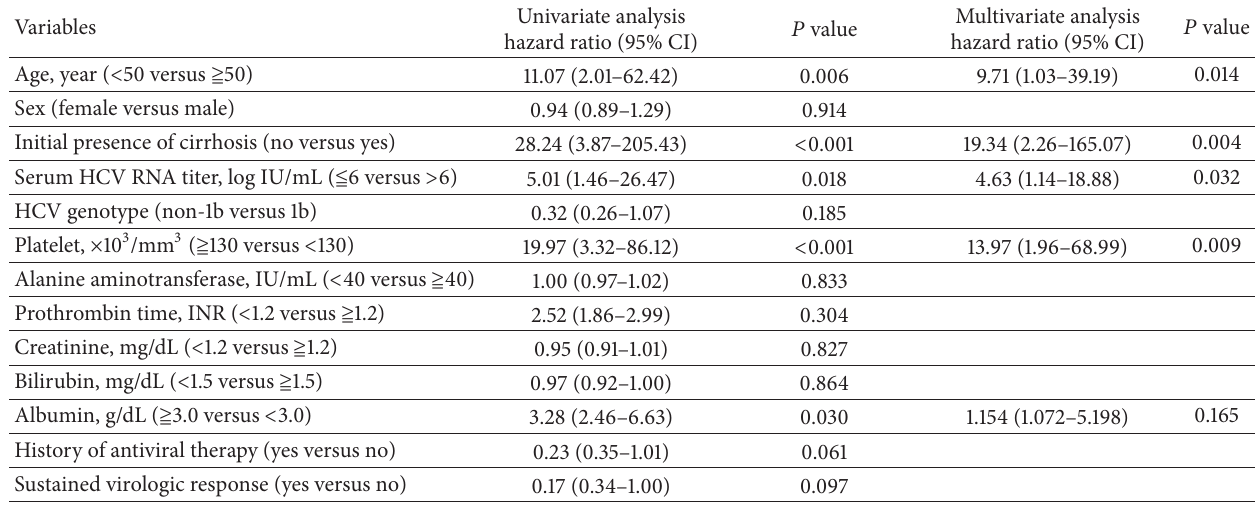
Table 2: Analysis of variables associated with the development of hepatocellular carcinoma.